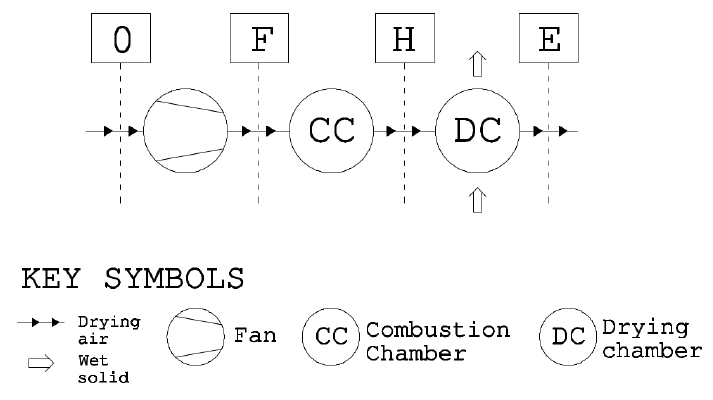
Figure 4. Baseline scenario corresponds to the layout of the case